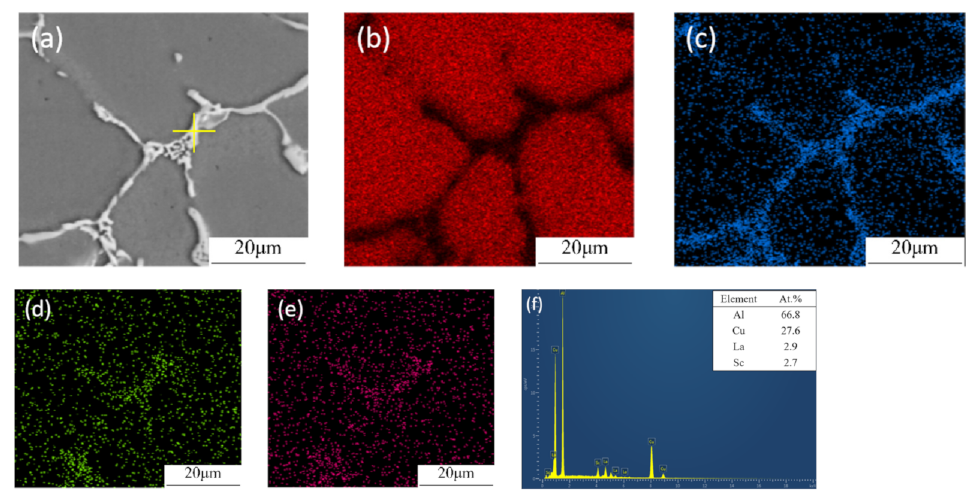
Figure 3. Map and point analysis of Al-Cu-La-Sc alloy ( a ) Backscattered electron image, ( b ) Image of Al, ( c ) Image of Cu, ( d ) Image of La, ( e ) Image of Sc, ( f ) Point